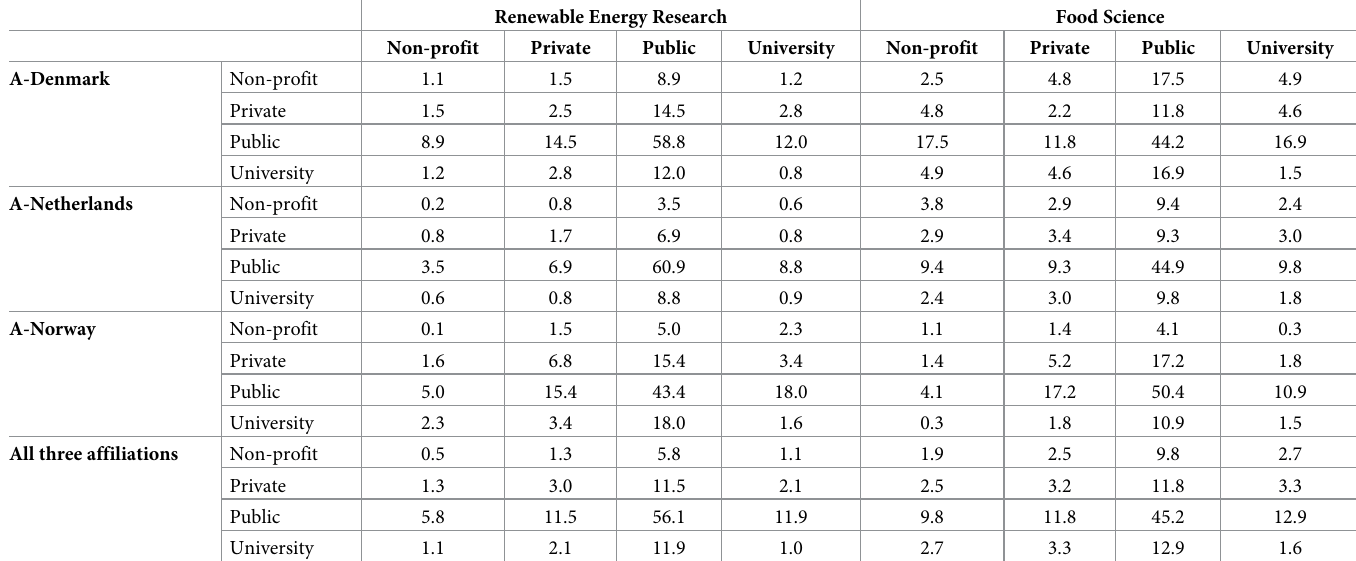
Table 6. Funding amalgamation patterns by instrument type,